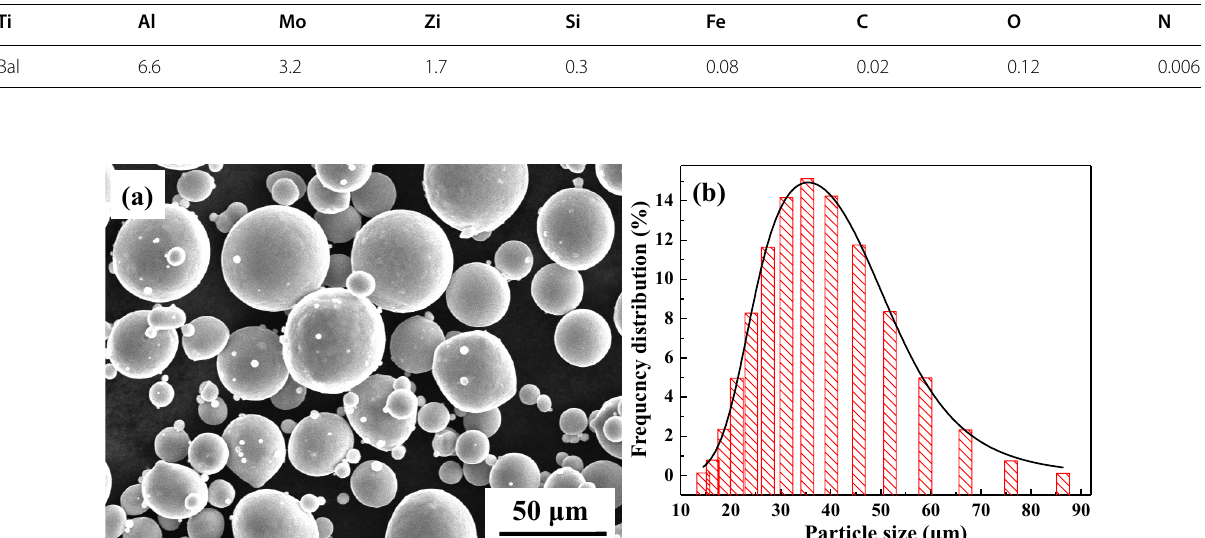
Figure 1 a Morphology and b size distribution of Ti-6.5Al-3.5Mo-1.5Zr-0.3Si powder